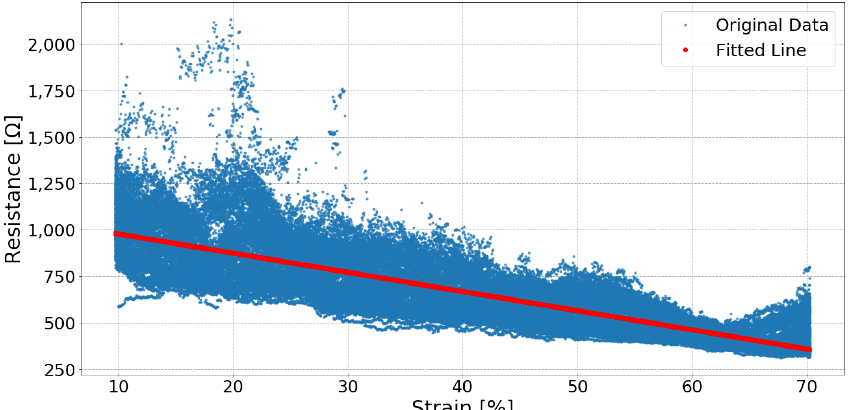
Figure 8. Sample 08, a lab-knitted sensor, response and fitted line of one hundred cycles of stretching between 10% strain and 70%